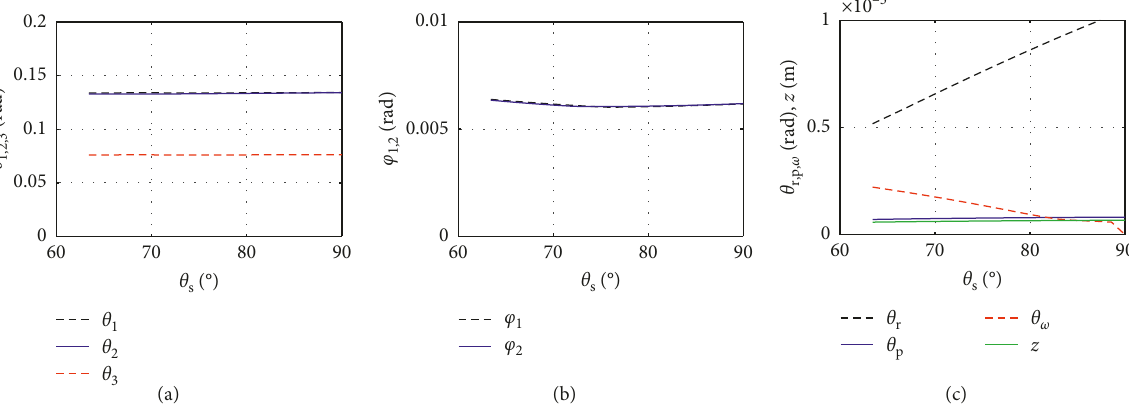
Figure 10: Influences of θ s on the amplitude of each DoF. (a) The amplitudes of θ 1,2,3 . (b) The amplitudes of φ 1,2 . (c) The amplitudes of θ r,p, ω , and z